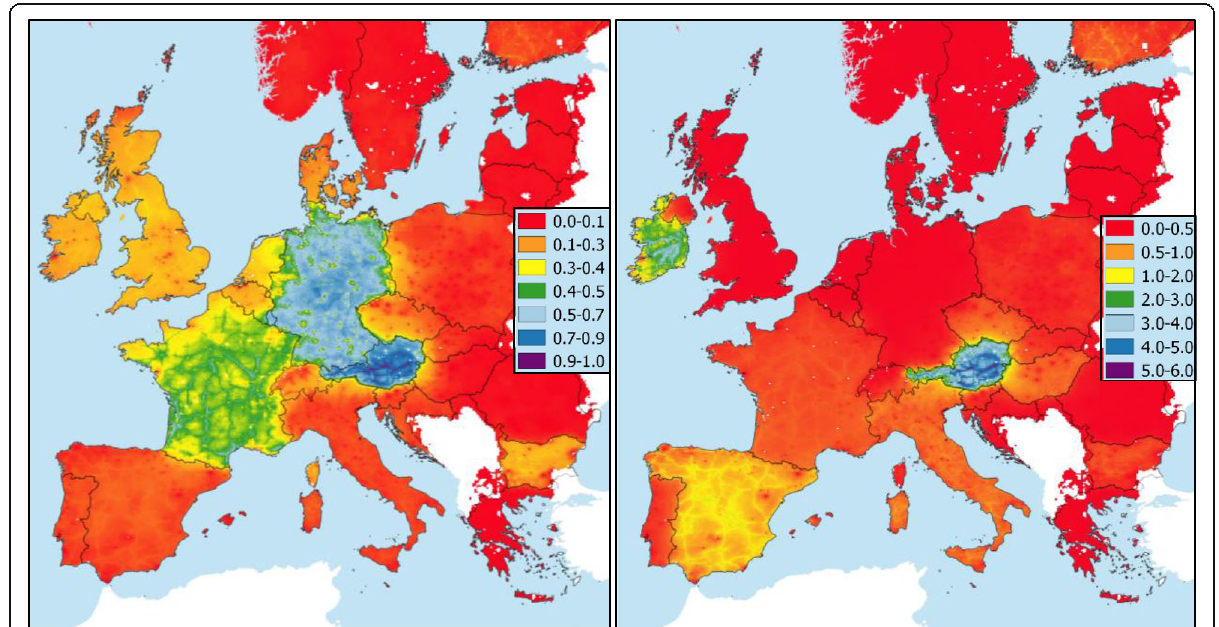
Fig. 9 NO 2 concentration reductions [%] in 2020 [left] and 2030 [right] (in the NPF scenario with respect to the base scenario). Source: based on EU [22]. Legend: note the change in scale